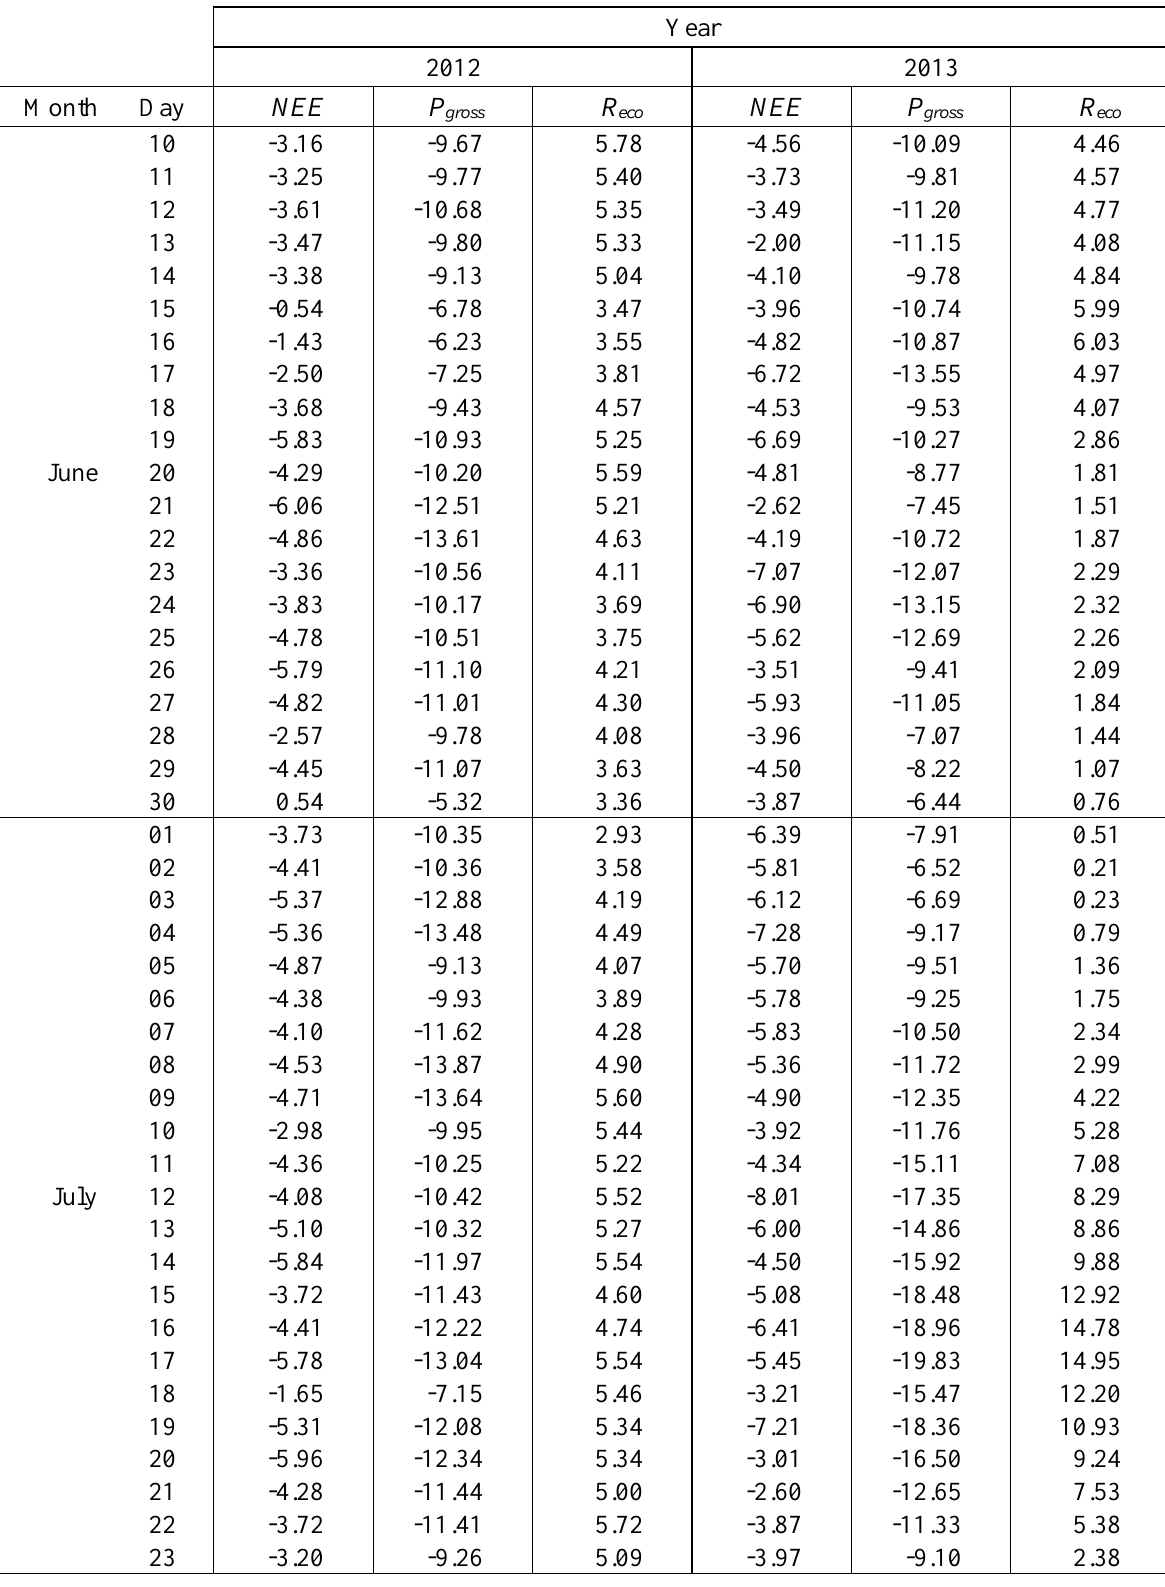
Table A1. Daily CO exchange fluxes (g m -2 d -1 ) for the 2012 and 2013 measurement 2